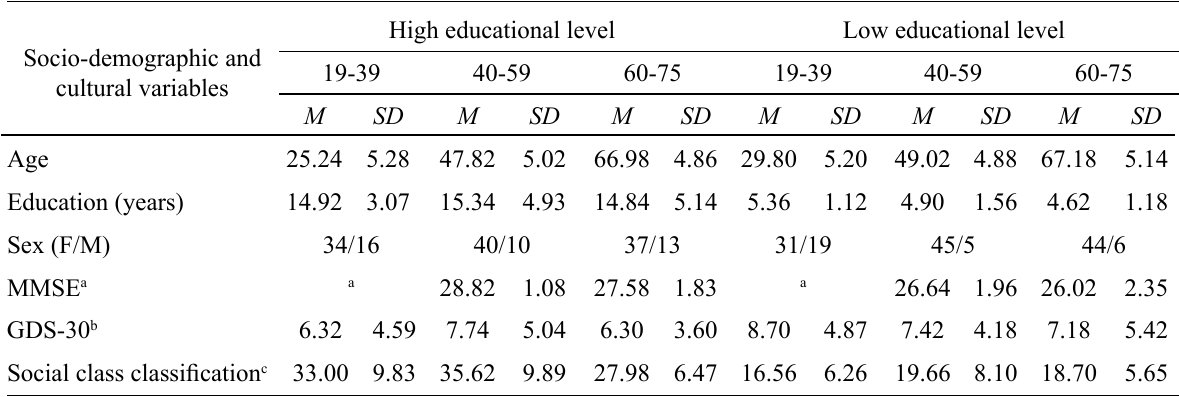
Means and Standard-Deviations of the Socio-Demographic and Cultural Variables According to Age and Education Socio-demographic and cultural